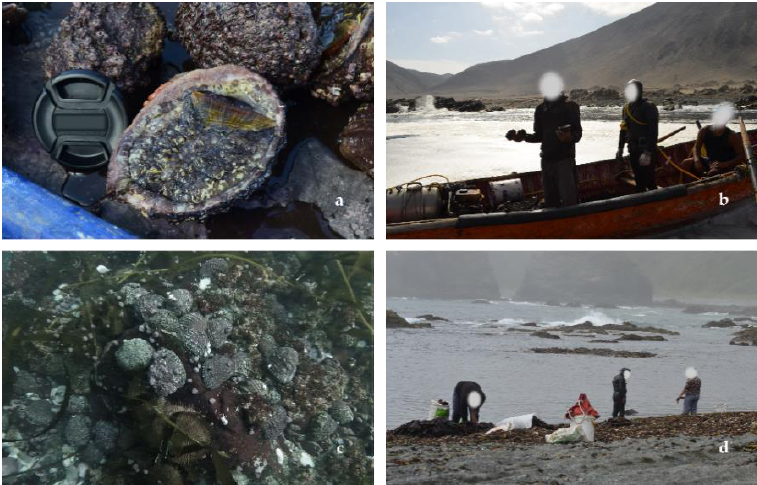
Figure 3. ( a ) Locos from an AMERB authorized harvest. ( b ) Small-scale fishing unit with